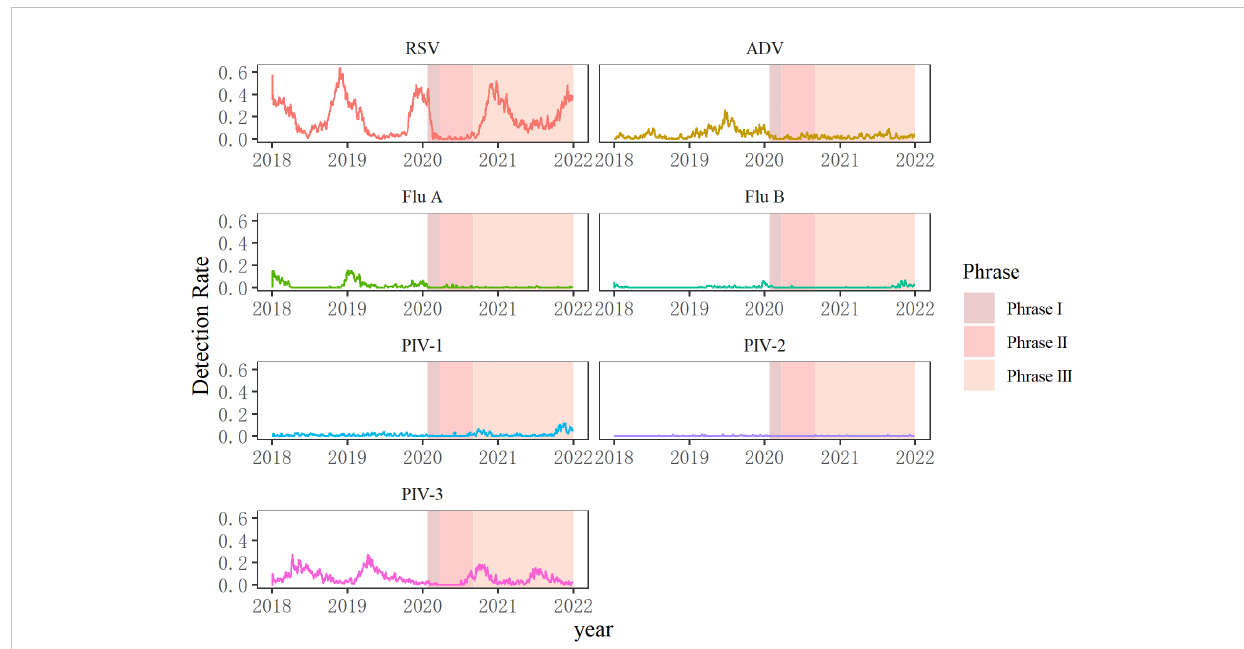
FIGURE 2 Seasonal patterns of viruses before the COVID-19 pandemic (2018 – 2019) and during the COVID-19 pandemic (2020 – 2021). Seven respiratory viruses were included: respiratory syncytial virus (RSV), adenovirus (ADV), in fl uenza virus A and B (Flu A, Flu B), and parain fl uenza virus types 1 – 3 (PIV1 –